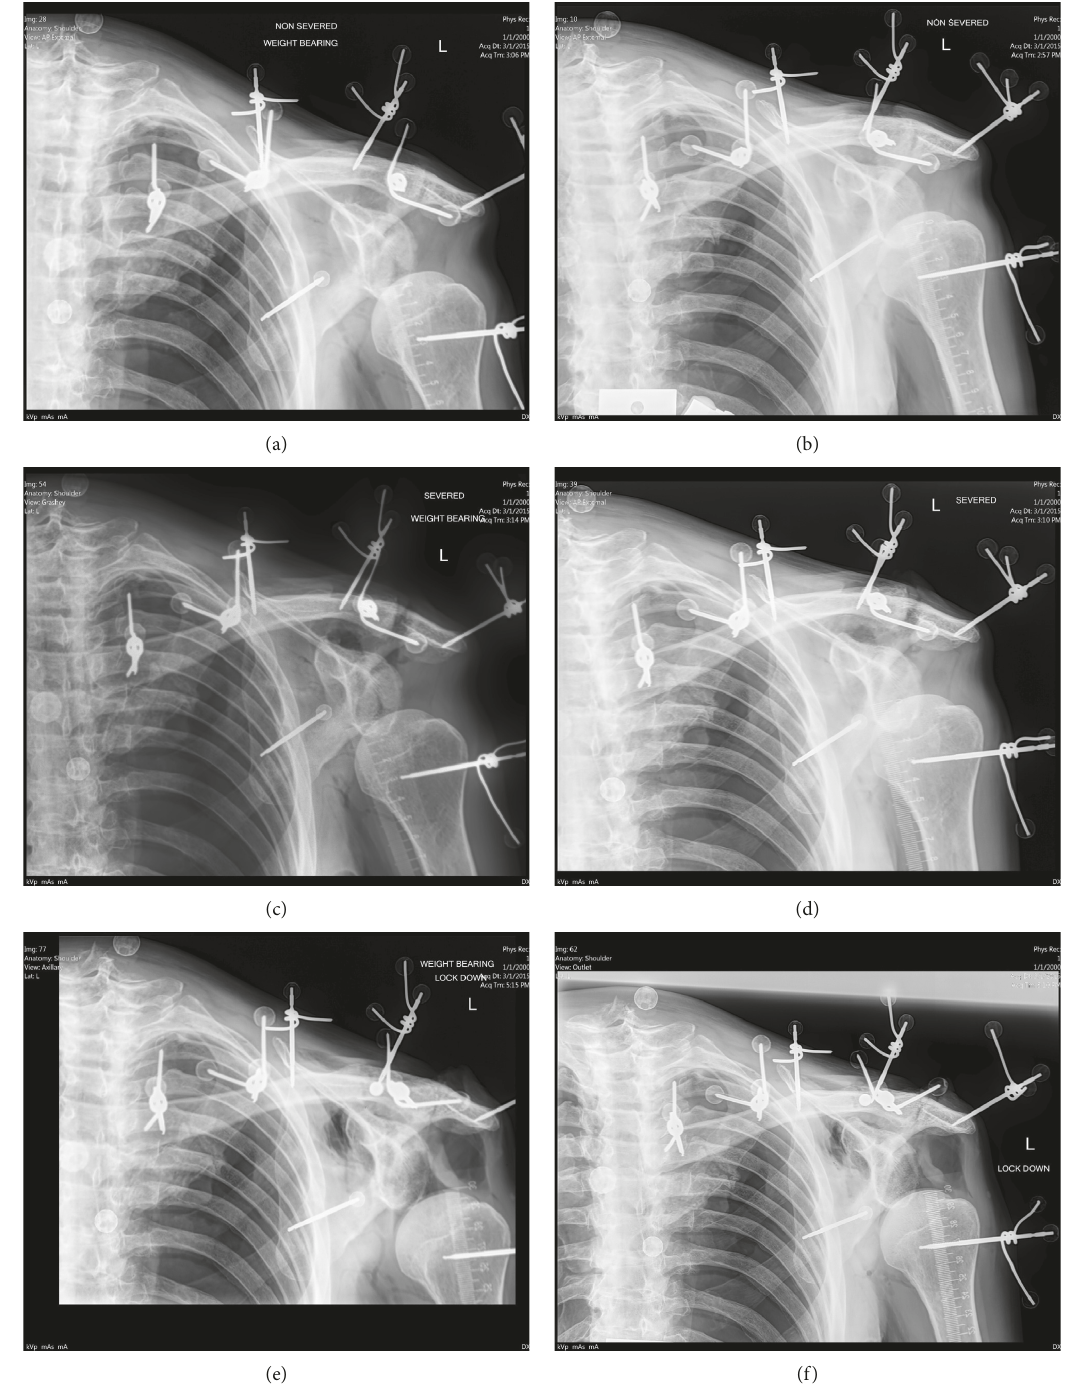
Figure 3: Radiographs were used to measure the coracoclavicular distances in the following states: “native” stressed (a), “native” unstressed (b), “severed” stressed (c), “severed” unstressed (d), “reconstructed” stressed (e), and “reconstructed” unstressed